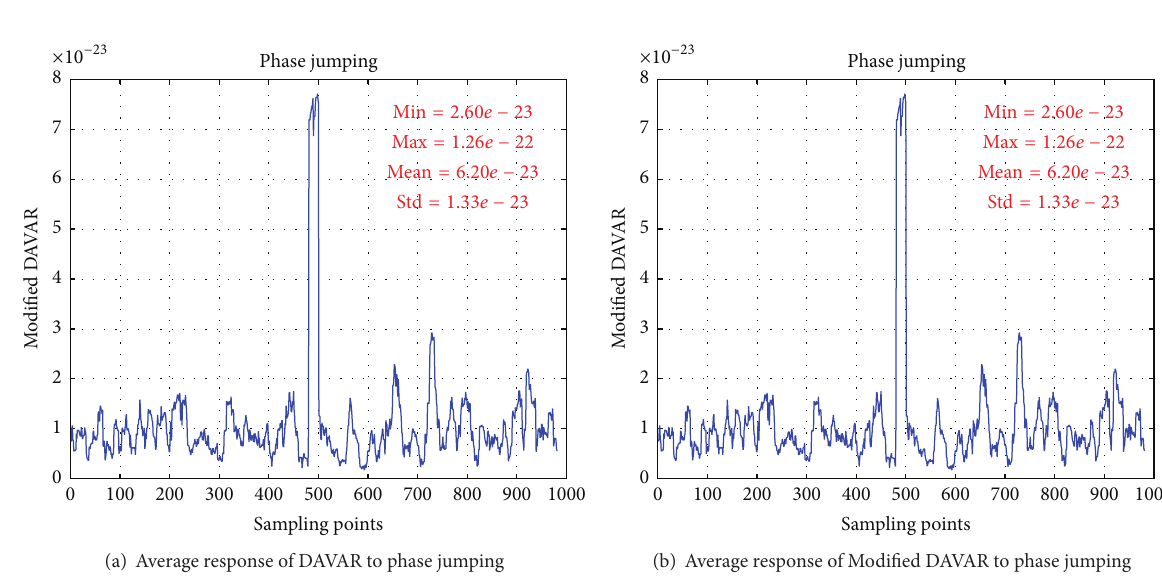
Figure 8: Comparison of two variances for phase